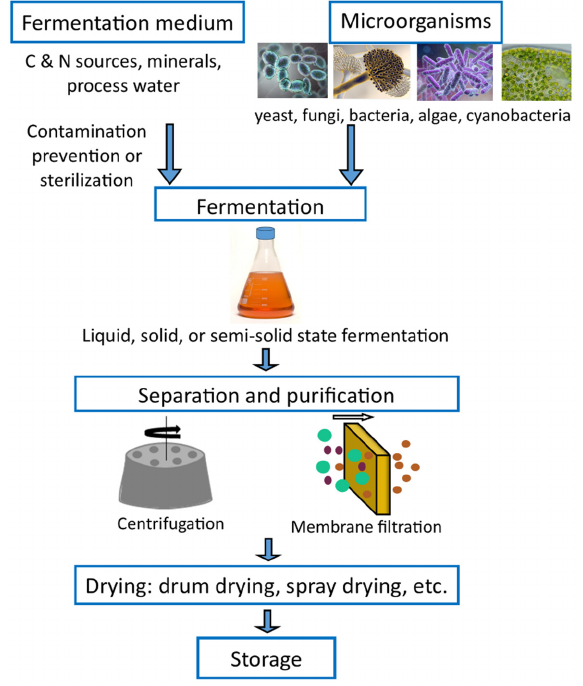
Figure 1. Schematic diagram depicting the SCP production.